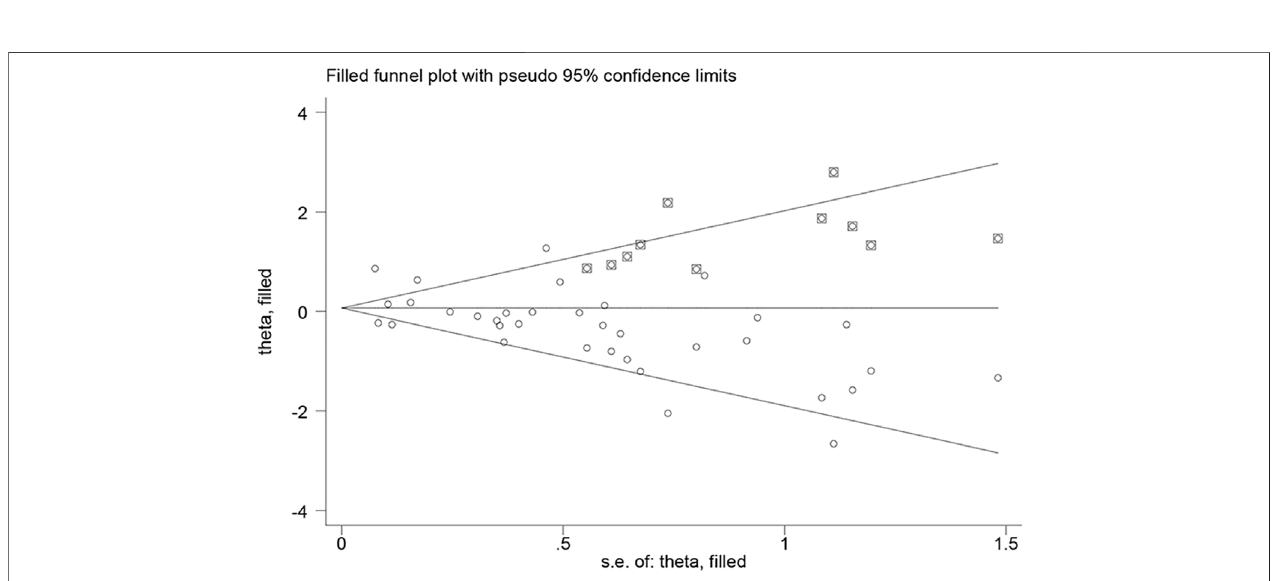
FIGURE 7 | Filled funnel plot of unadjusted data for severe ROP showing number of potential missing studies.